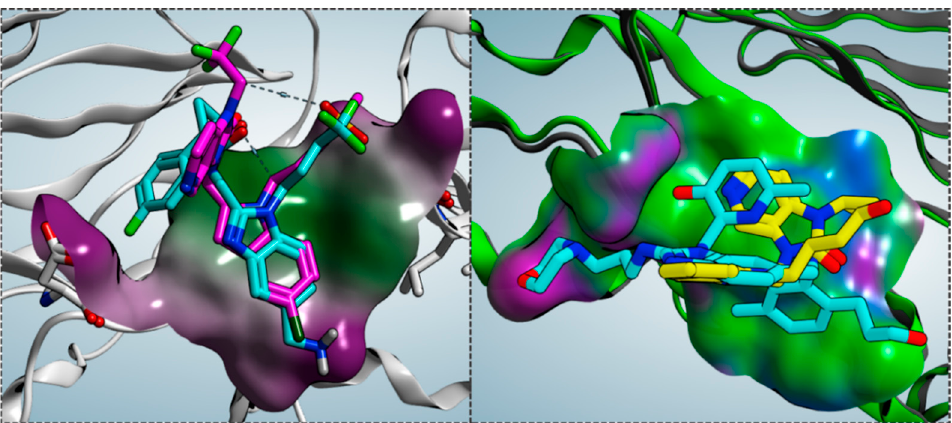
Figure 5. Molecular electrostatic properties at the RSV F protein surface surrounding the RV521 (C atom in cyan; pdb code = 7KQD) and JNJ-53718678 (C atom in magenta; pdb code = 5KWW) inhibitors ( left side ). The binding mode of TMC-353121 (C atom in cyan; pdb code = 5EA5) and BMS-433771 (C atom in yellow; pdb code = 5EA7) is also shown ( right side ).